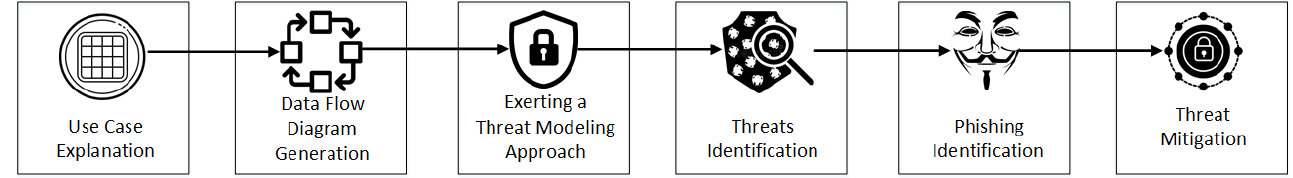
Figure 4. Proposed Methodology for Identification and Mitigation of Phishing Attacks in Internet of Things Smart Home and Smart Autonomous Vehicle System